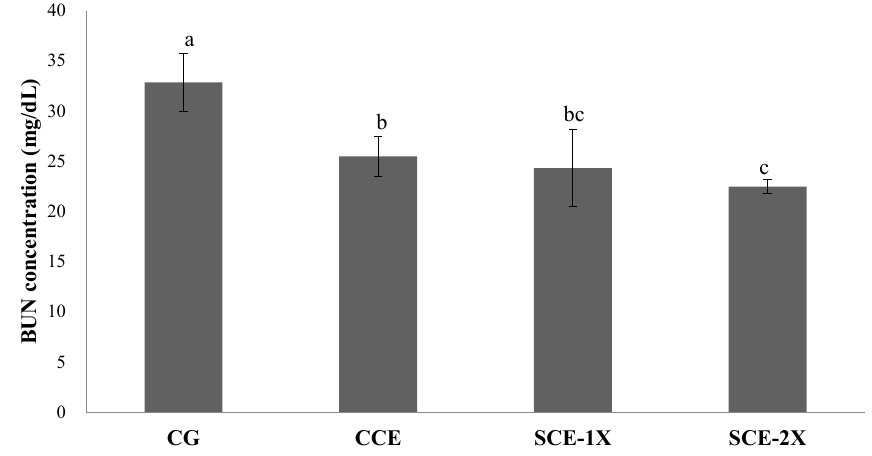
Figure 4. The blood urea nitrogen concentration of different treatments in mice. Values are means±standard deviation for n = 8 mice per group. a-c Bars with different letters are significantly different at p<0.05. CG, control group; CCE, commercial dripped chicken essence; SCE-1X, spent hen dripped chicken essence; SCE-2X, double dosage of spent hen dripped chicken essence.